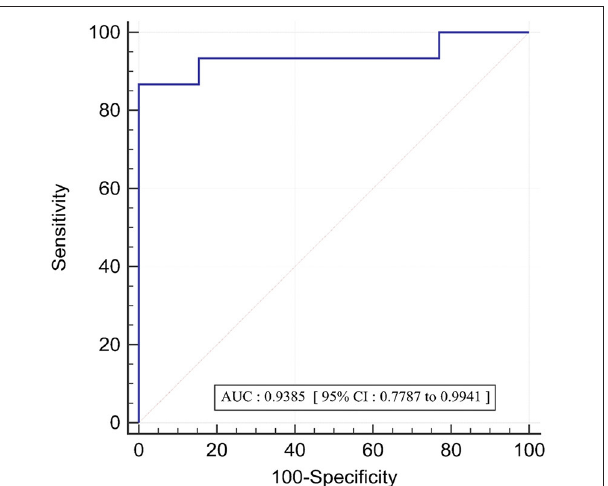
FIGURE 5 | ROC curve for the prediction of functionally significant stenoses (FFR < = 0.80) by FFR 3D ; AUC, area under the curve; ROC, receiver operating